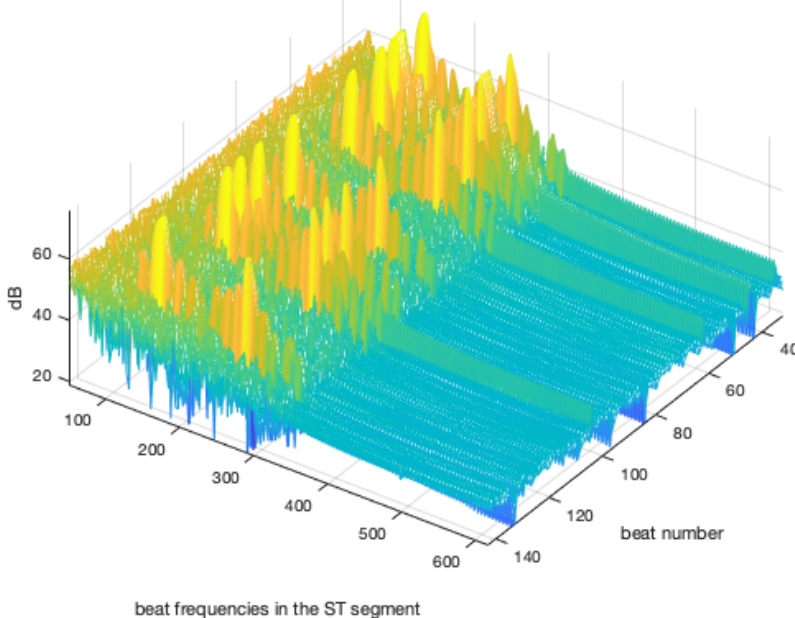
Figure 6. Spectrogram of some ST segments extracted from the